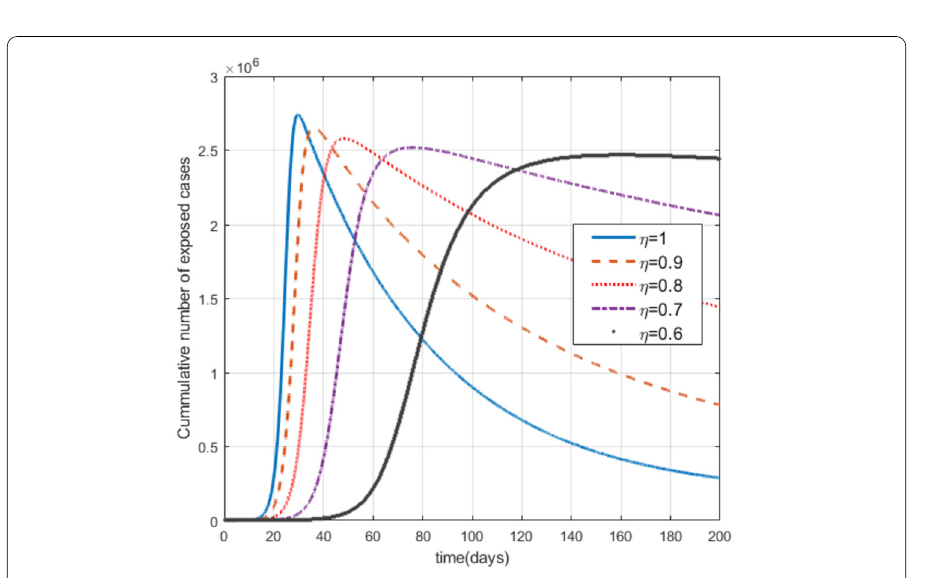
Figure 3 Total number of exposed (E) cases for different values of